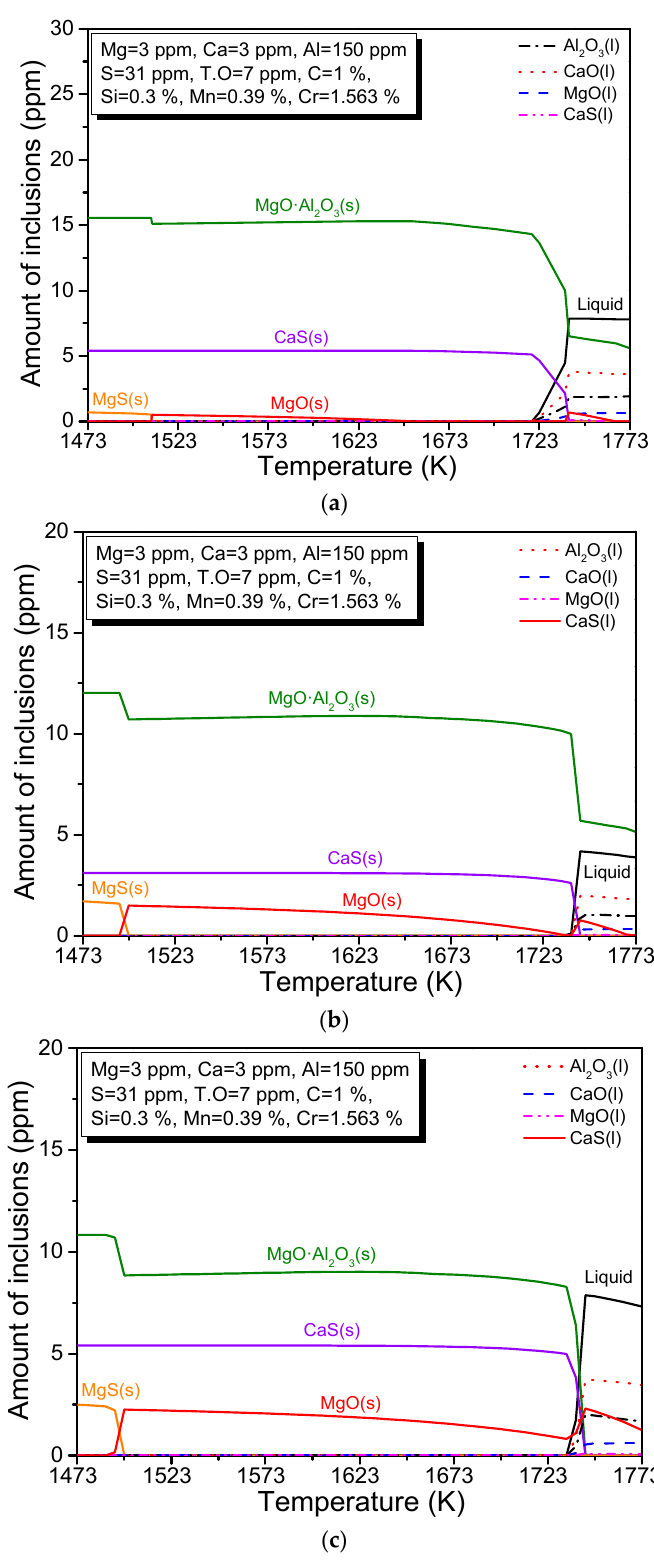
Figure 18. Precipitation of inclusions in the bearing steel at various temperature with 7 ppm T.O.: ( a ) Comprehensive transformation, ( b ) new precipitates from the steel, ( c ) transformation of inclusions from the reaction between steel and inclusions.